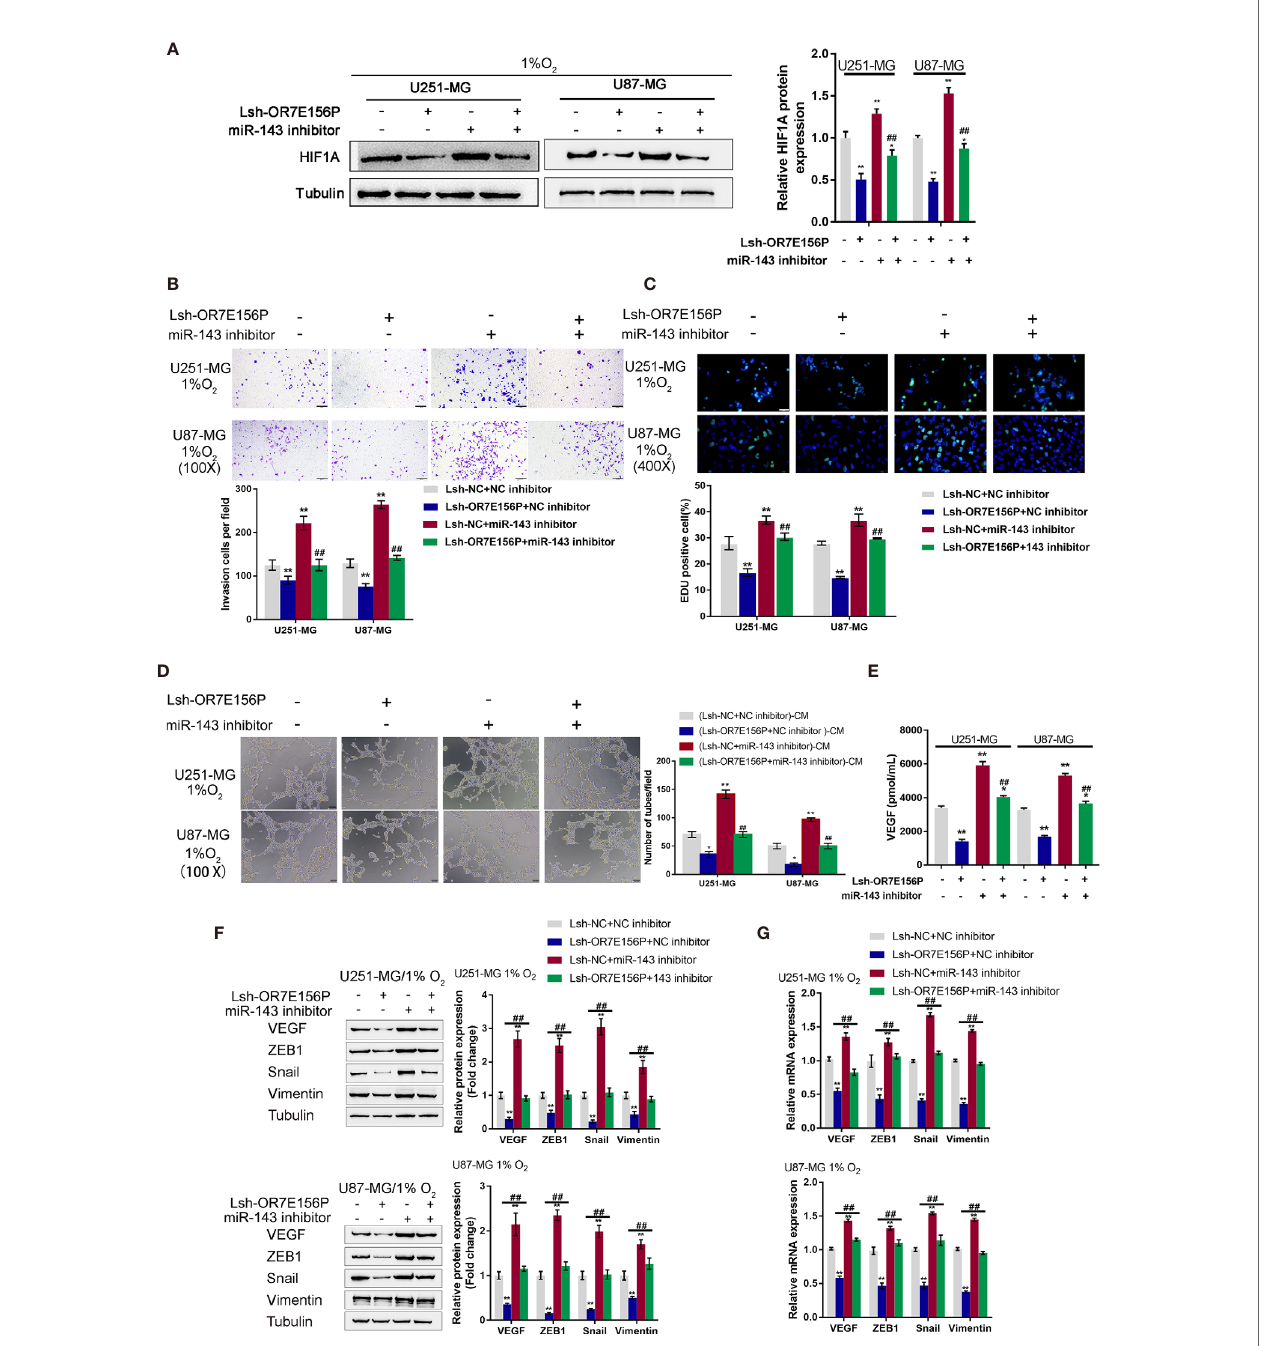
FIGURE 6 | Dynamic effects of OR7E156P and miR-143 on HUVEC tube formation and glioma cell invasion (A) U251-MG and U87-MG cells were co-transfected with Lsh-OR7E156P and miR-143 inhibitor, exposed to 1% oxygen, and examined for the protein levels of HIF1A using Immunoblotting. (B) U251-MG and U87-MG cells were co-transfected with Lsh-OR7E156P and miR-143 inhibitor, exposed to 1% or 20% oxygen, and examined for the cell invasion by Transwell. (C) U251-MG and U87-MG cells were co-transfected with Lsh-OR7E156P and miR-143 inhibitor and exposed to 1% or 20% oxygen, and then examined for DNA synthesis ability by EdU assay; (D) U251-MG and U87-MG cells were co-transfected with Lsh-OR7E156P and miR-143 inhibitor and exposed to 1% or 20% oxygen. The culture medium was collected for HUVEC incubation. The tube formation ability of HUVEC was determined. (E) U251-MG and U87-MG cells were co-transfected with miR- 143 inhibitor and Lsh-OR7E156P, exposed to 1% oxygen, and examined for the VEGF levels in culture medium by ELISA. * P < 0.05, ** P < 0.01, compared to the control group; ## P < 0.01, compared to the Lsh-NC + miR-143 inhibitor group. (F) U251-MG and U87-MG cells were co-transfected with Lsh-OR7E156P and miR- 143 inhibitor, exposed to 1% oxygen, and examined for the protein levels of VEGF, ZEB1, Snail, and Vimentin by Immunoblotting. (G) U251-MG and U87-MG cells were co-transfected with Lsh-OR7E156P and miR-143 inhibitor, exposed to 1% oxygen, and examined for the mRNA levels of VEGF, ZEB1, Snail, and Vimentin by real-time qPCR. * P < 0.05, ** P < 0.01, compared to the control group; ## P < 0.01, compared to the Lsh-OR7E156P + NC inhibitor